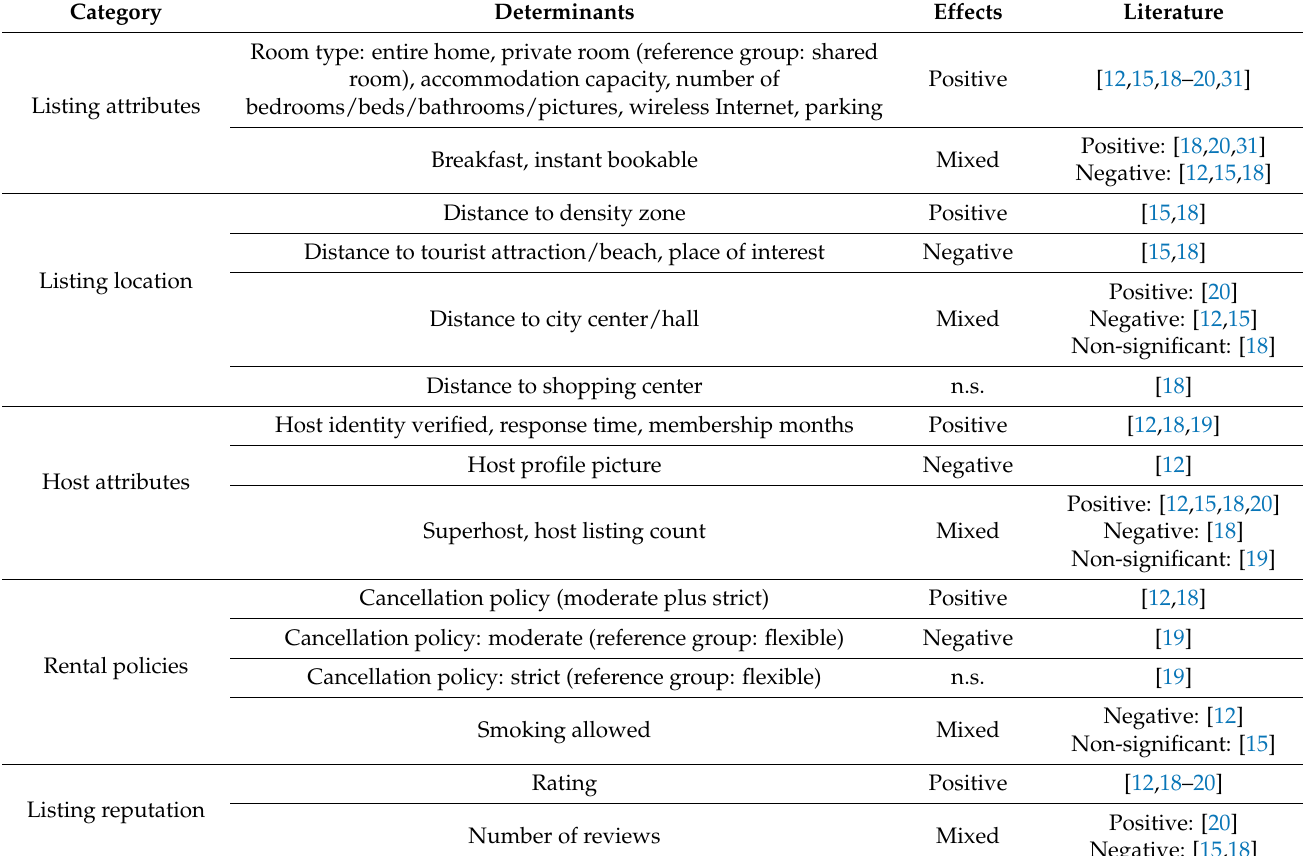
Table 1. Studies on price determinants of sharing economy-based accommodation